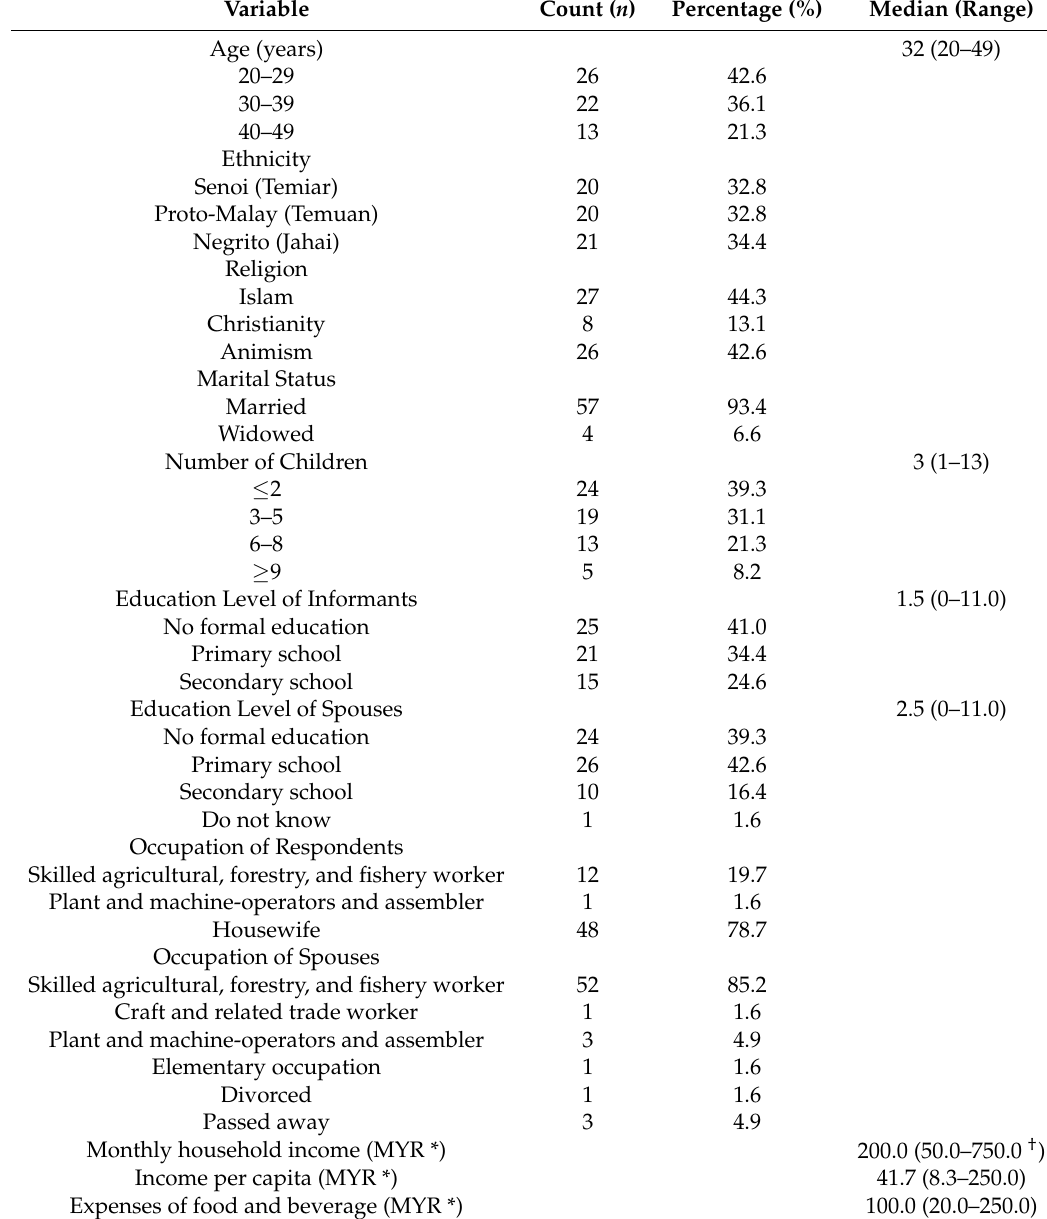
Table 1. Sociodemographic characteristics of the informants ( n =